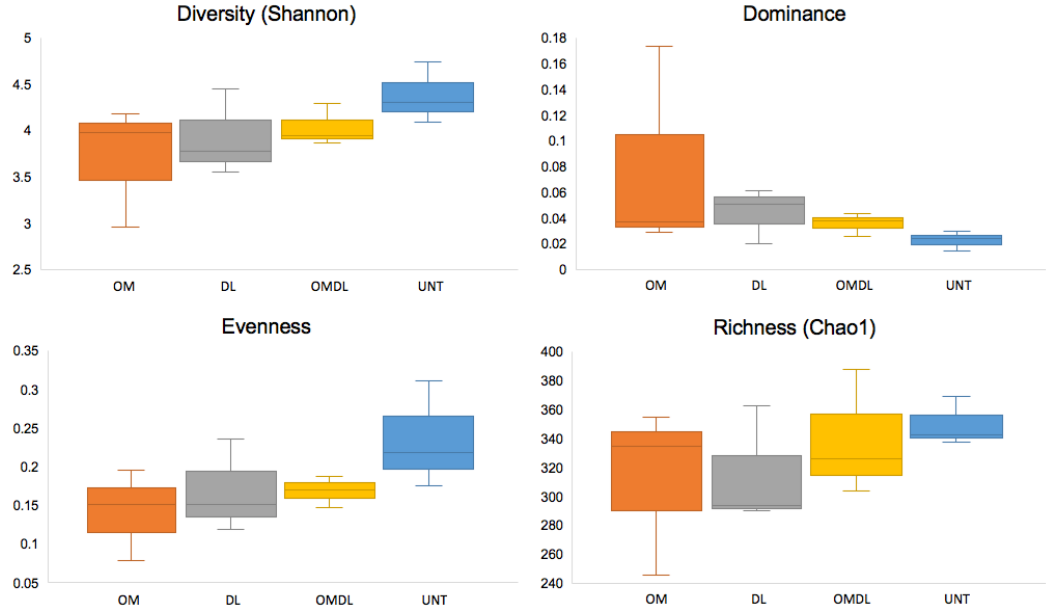
Figure 4. Values of alpha-diversity of the bacterial community of leachates from untreated and phytomanaged soils. Black bar corresponds to the median. No significant differences were observed ( p > 0.05).